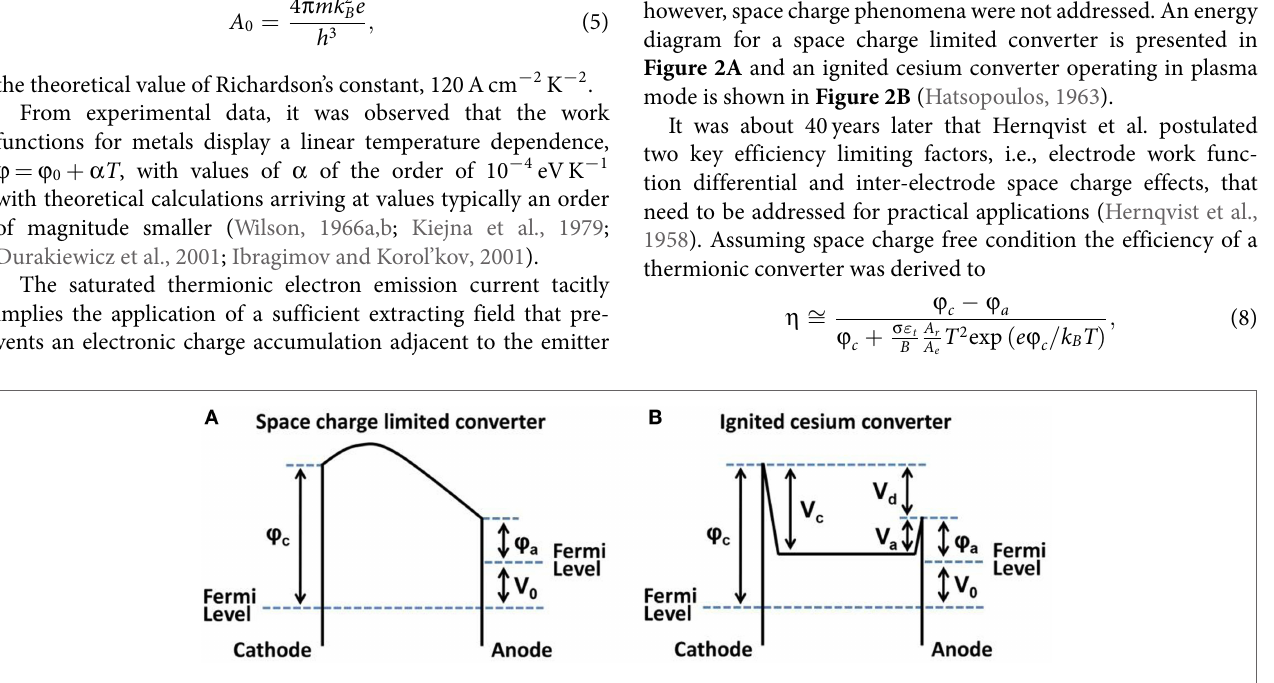
FIGURE 2 | Energy diagram for a space charge limited converter (A) and an ignited cesium converter in plasma mode (B) ; the work function of cathode (emitter) is ϕ c and anode (collector) ϕ a